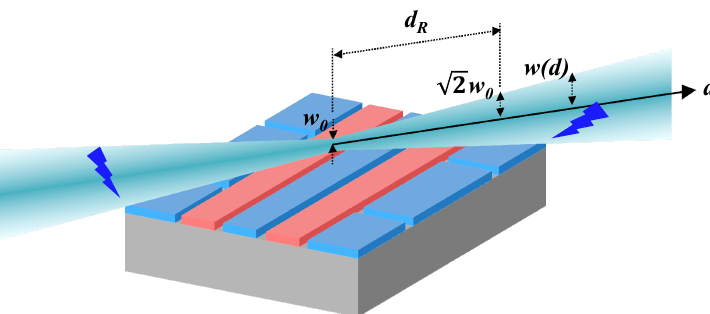
Figure 4. Schematic of a Gaussian beam injected parallel to the surface ion trap. The blue lightning symbols indicate the scattering of the Gaussian beam by the surface ion-trap chip at the chip edges.